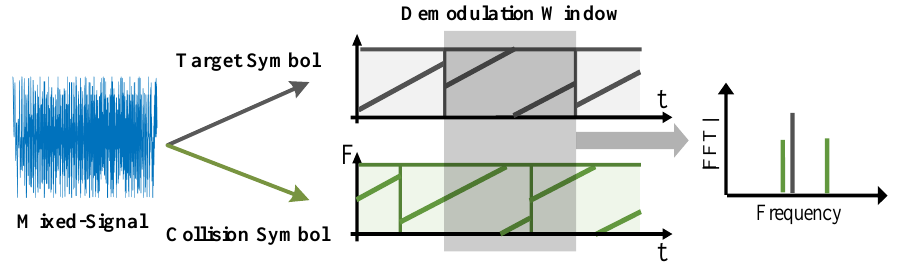
Figure 3. Example of LoRa